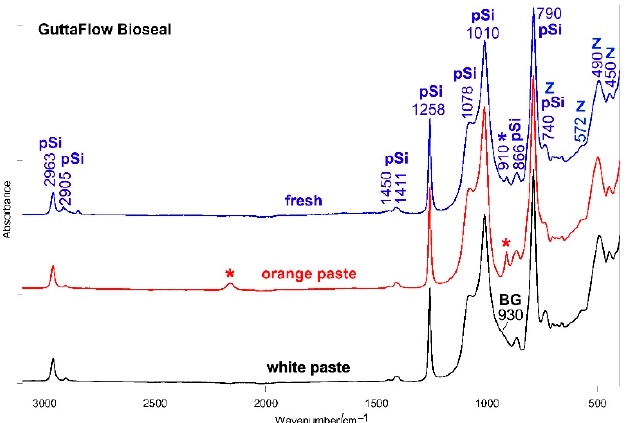
Figure 3. The average IR spectrum of fresh (i.e., just mixed) GuttaFlow Bioseal; the spectra of its white and orange pastes are reported for comparison. The spectra are normalized to the absorbance of the 2963 cm − 1 band. The bands assignable to polydimethylsiloxane (pSi), monoclinic zirconia (Z), and bioactive glass ‐ ceramic (BG) are indicated together with those specifically assigned to Si ‐ H bonds (*). More detailed assignments are summarized in Table S1, Supplementary Material.